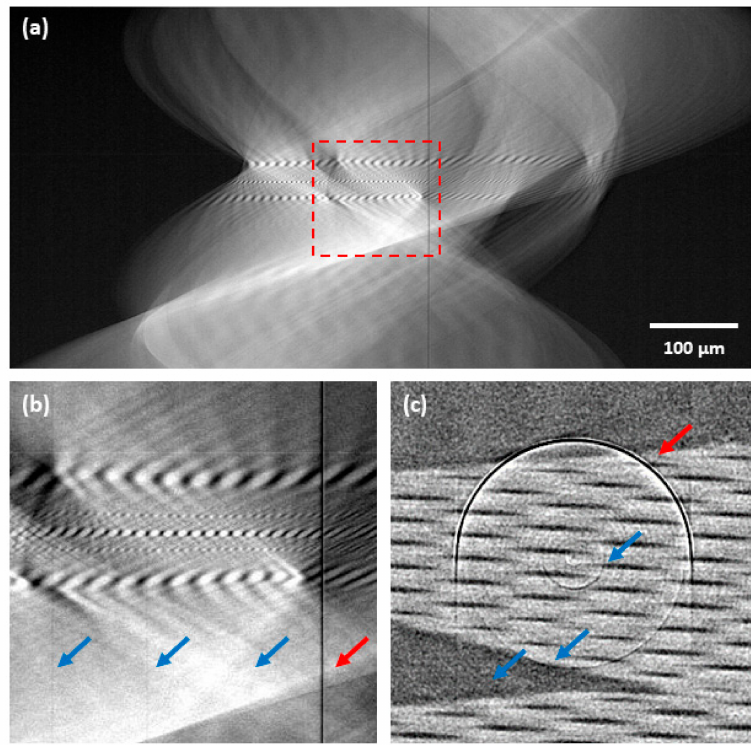
Figure 1. Example of ring artifacts affected data—glass capillary sample acquired with a charge- coupled device (CCD)-based camera: ( a ) sinogram; ( b ) detail of sinogram central area; ( c ) central area of corresponding tomogram. Red arrows indicate the high-level ring artifacts and blue arrows the low-level ring